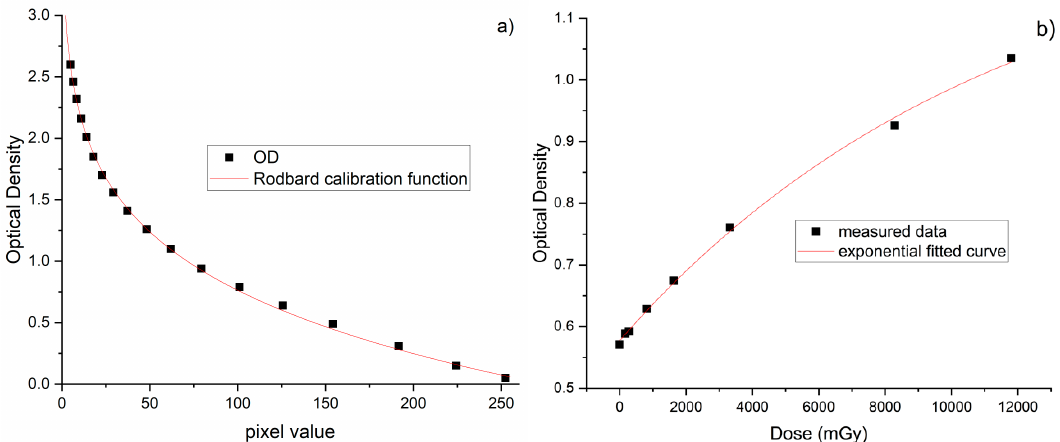
Figure 3. ( a ) Pixel values to optical density Rodbard calibration curve. ( b ) The dependence of optical density on radiation dose.